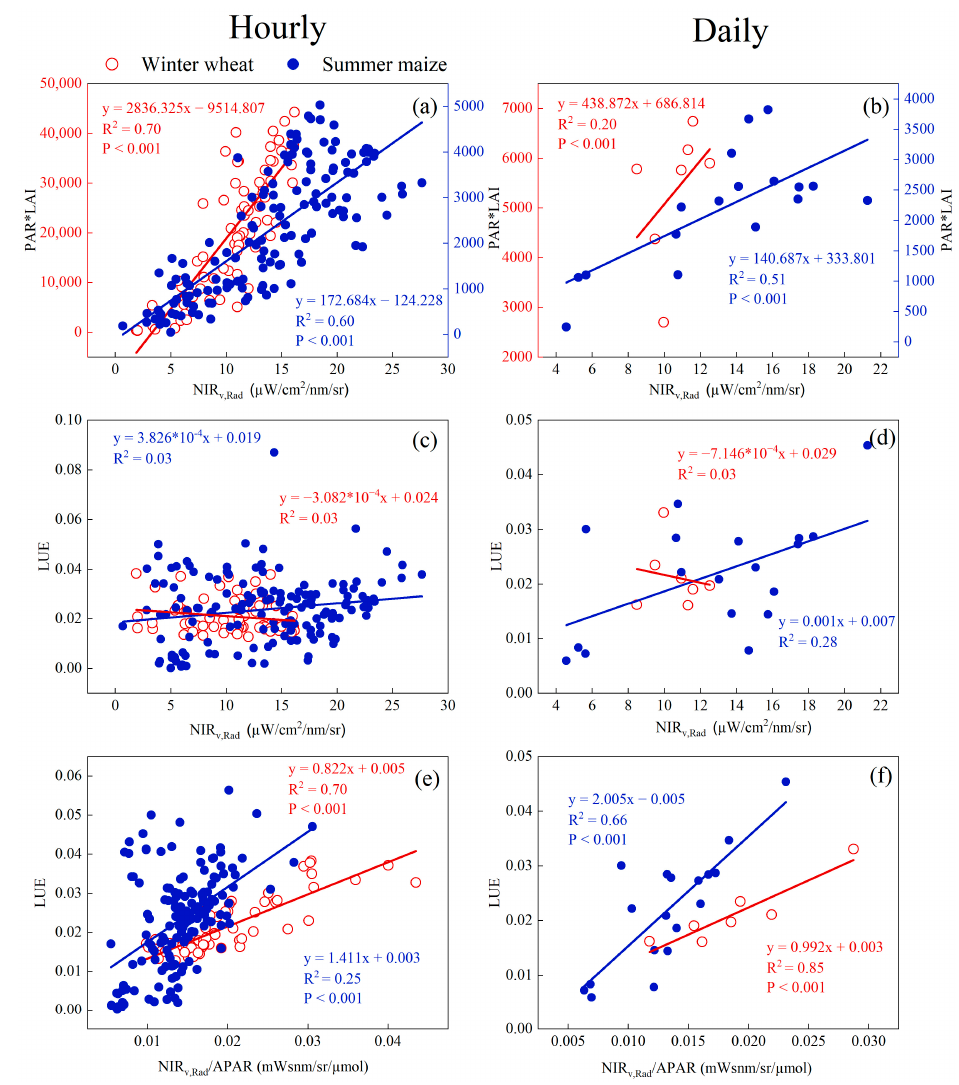
Figure 7. PAR*LAI–NIR v,Rad , LUE–NIR v,Rad , and LUE–NIR v,Rad /APAR relationships in winter wheat and summer maize on hourly and daily scales. Red and blue lines in each panel represent the regression between the LUE and VIs of winter wheat and summer maize, respectively.